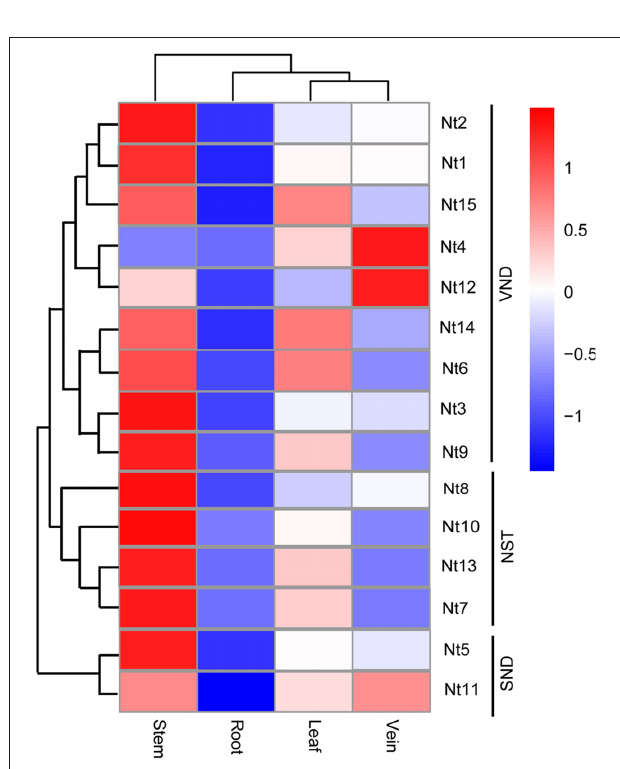
FIGURE 5 | Expression profile of NtSWN genes in tissues. Expression patterns of the NtSWNs in the root, stem, leaf, and vein of 3-week-old seedlings.